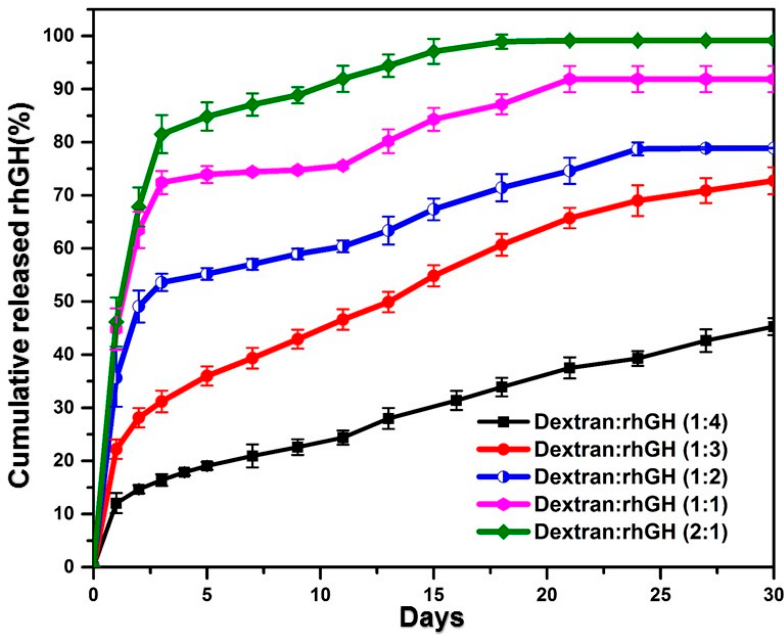
Figure 6. In vitro release profile of rhGH loaded PLGA microspheres with different dextran and rhGH ratios ( n = 5, p < 0.05).